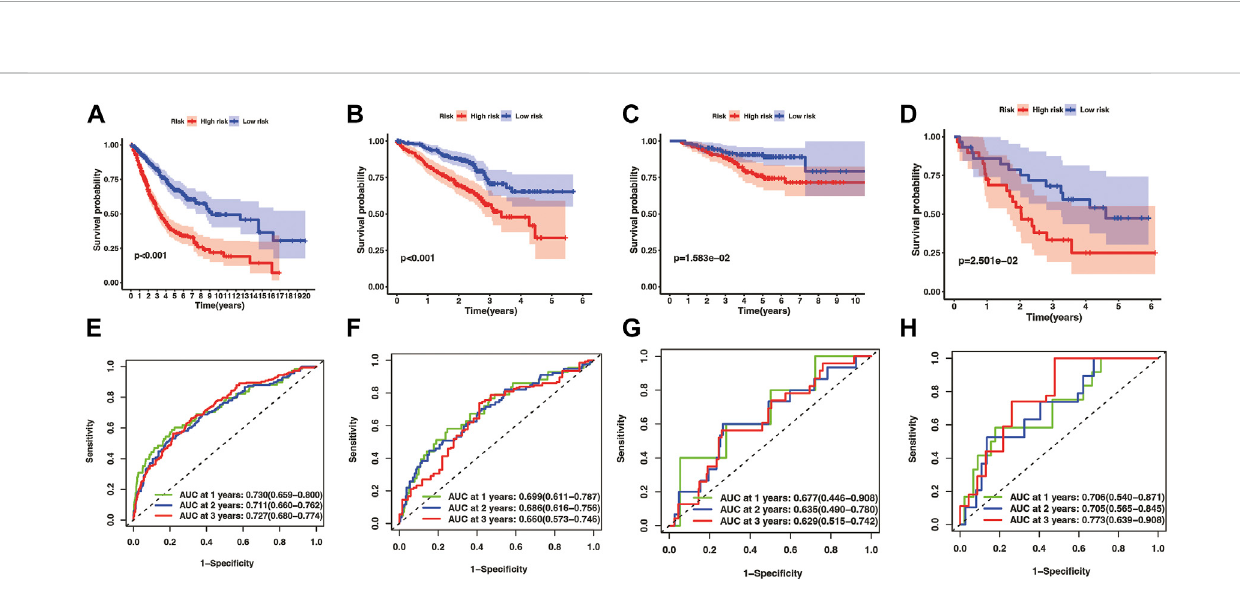
FIGURE 5 Evaluation of prognostic model in training and test cohorts, including merge cohort (A,E) , GSE72094 (B,F) , GSE31210 (C,G) , and GSE3141 (D,H) . The overall survival KM curves showed that LUAD patients in the high-risk group had a shorter OS time comparing with the low-risk group (A – D) pictures from (E – H) were timeROC curves of 1, 2, and 3 year overall survival time, which showed that the prognostic model had an excellent 1, 2, and 3 year OS time predicting